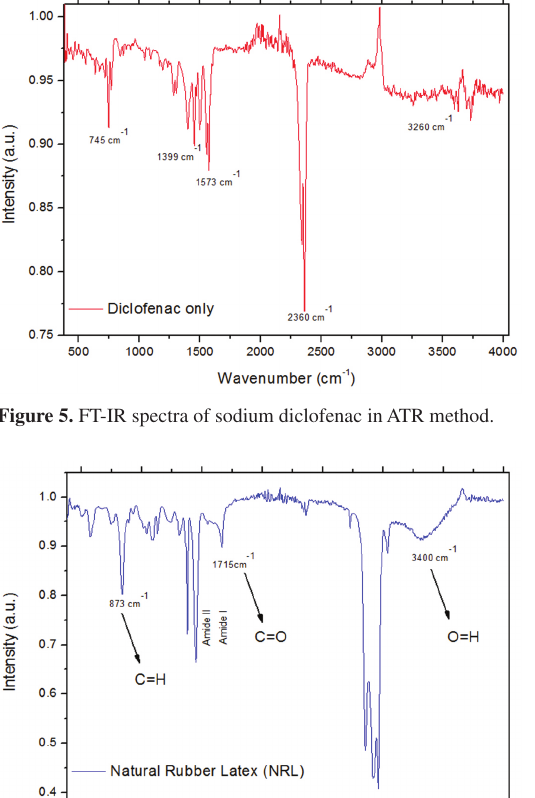
(Figure 5) exhibited distinctive peaks at 3381.57 cm −1 due to NH stretching of the secondary amine, 1572.66 cm −1 owing to –C = O stretching of the carboxyl ion and at 745.35 cm −1 because of C-Cl stretching 27 . FT-IR spectra of natural rubber is presented in Figure 6. The cis-1,4-polyisoprene absorption band of strong amplitude corresponding to =CH out of plane